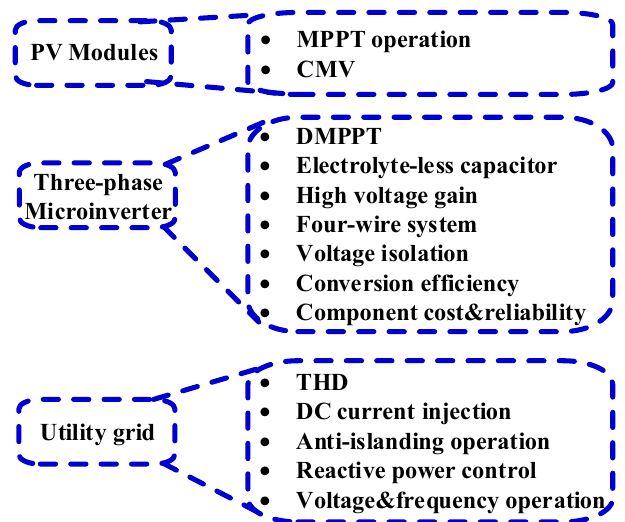
Figure 3. Main parts of three-phase inverters with performance features for each part. Abbreviations: MPPT = maximum power point tracking; CMV = common mode voltage; DMPPT = distributed maximum power point tracking; THD = total harmonic distortion.